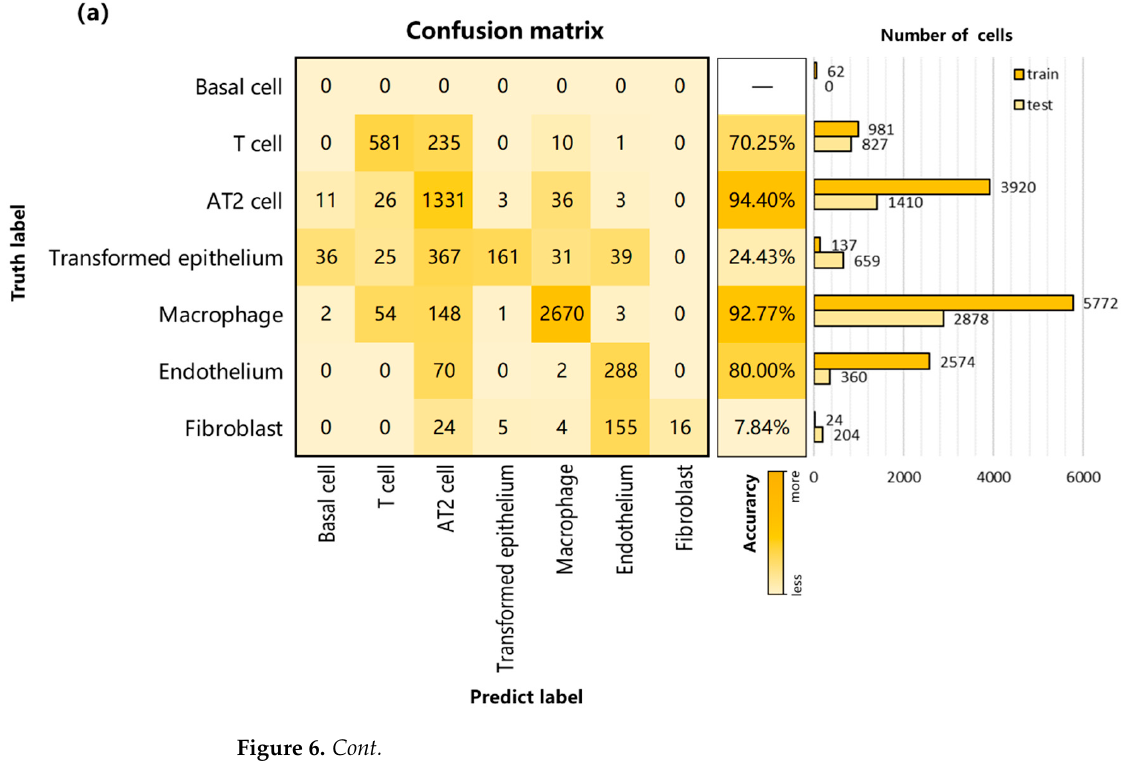
Figure 5. Performance comparison of scTransSort on mouse external test datasets (accessed on 1 June 2022). ( a ) Heat maps and boxplots of accuracy comparisons for different methods on 29 da- tasets from 12 tissues; ( b ) Heat maps and boxplots of the mean F1 score comparison; ( c ) Heat maps and boxplots of the mean MCC comparison. The bolded font indicates the top-ranked method for each dataset; ( d ) The bubble charts summarize the accuracy, mean F1 score, and mean MCC of the different methods in each tissue.